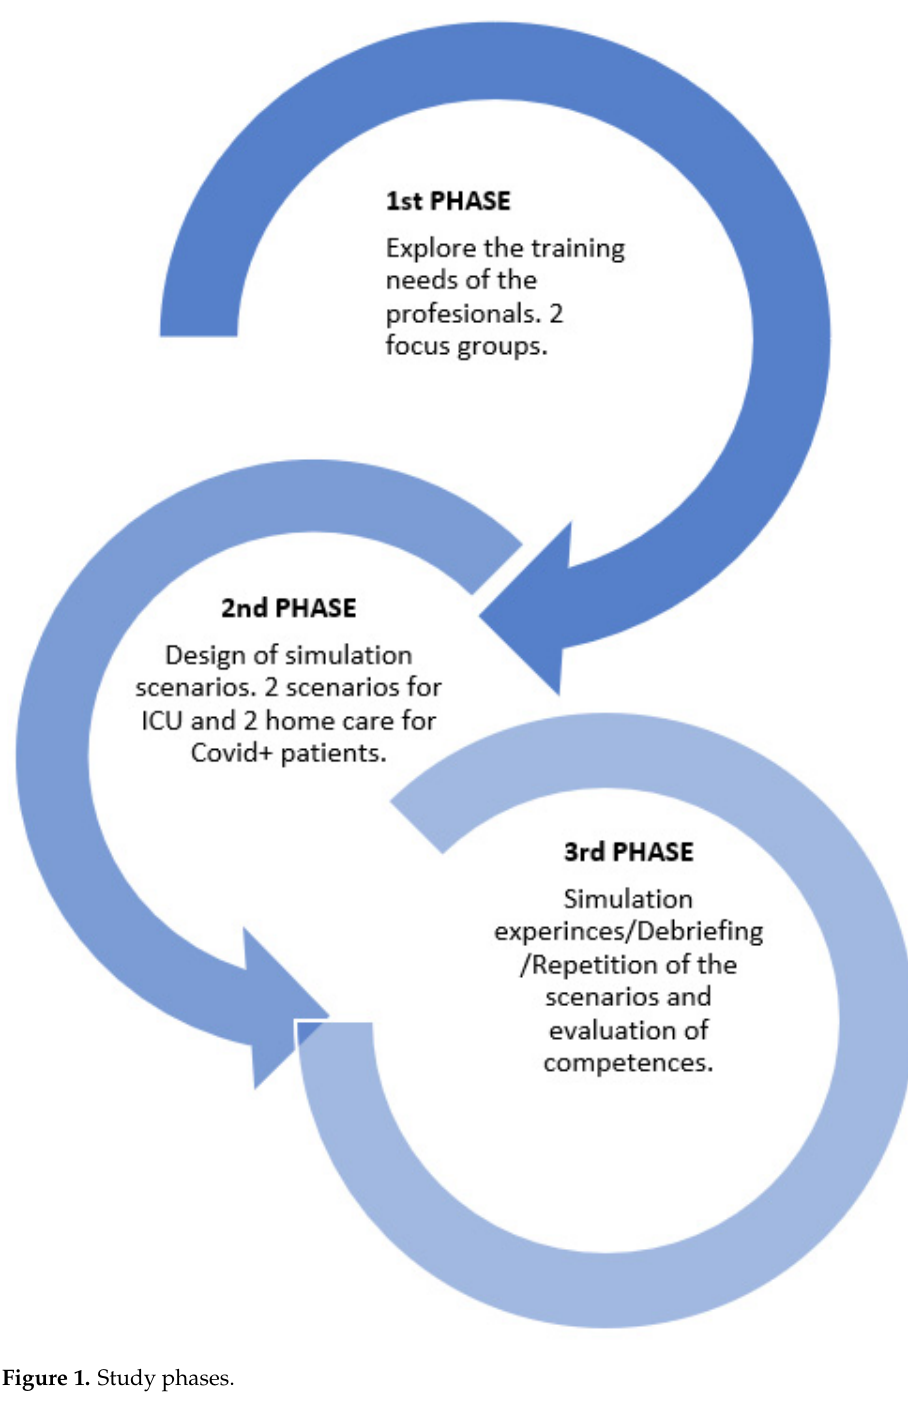
Figure 1. Study phases.